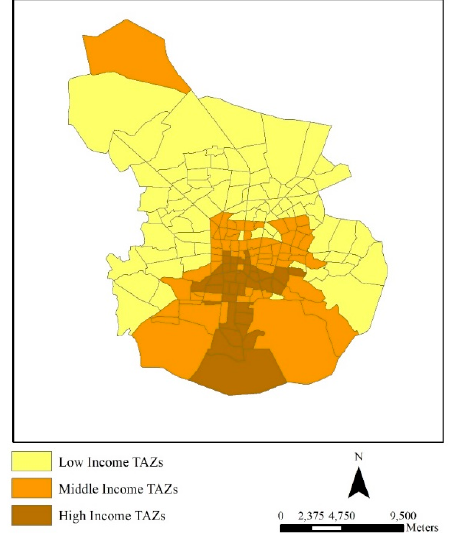
Figure 3. Income distribution in the city of Isfahan.